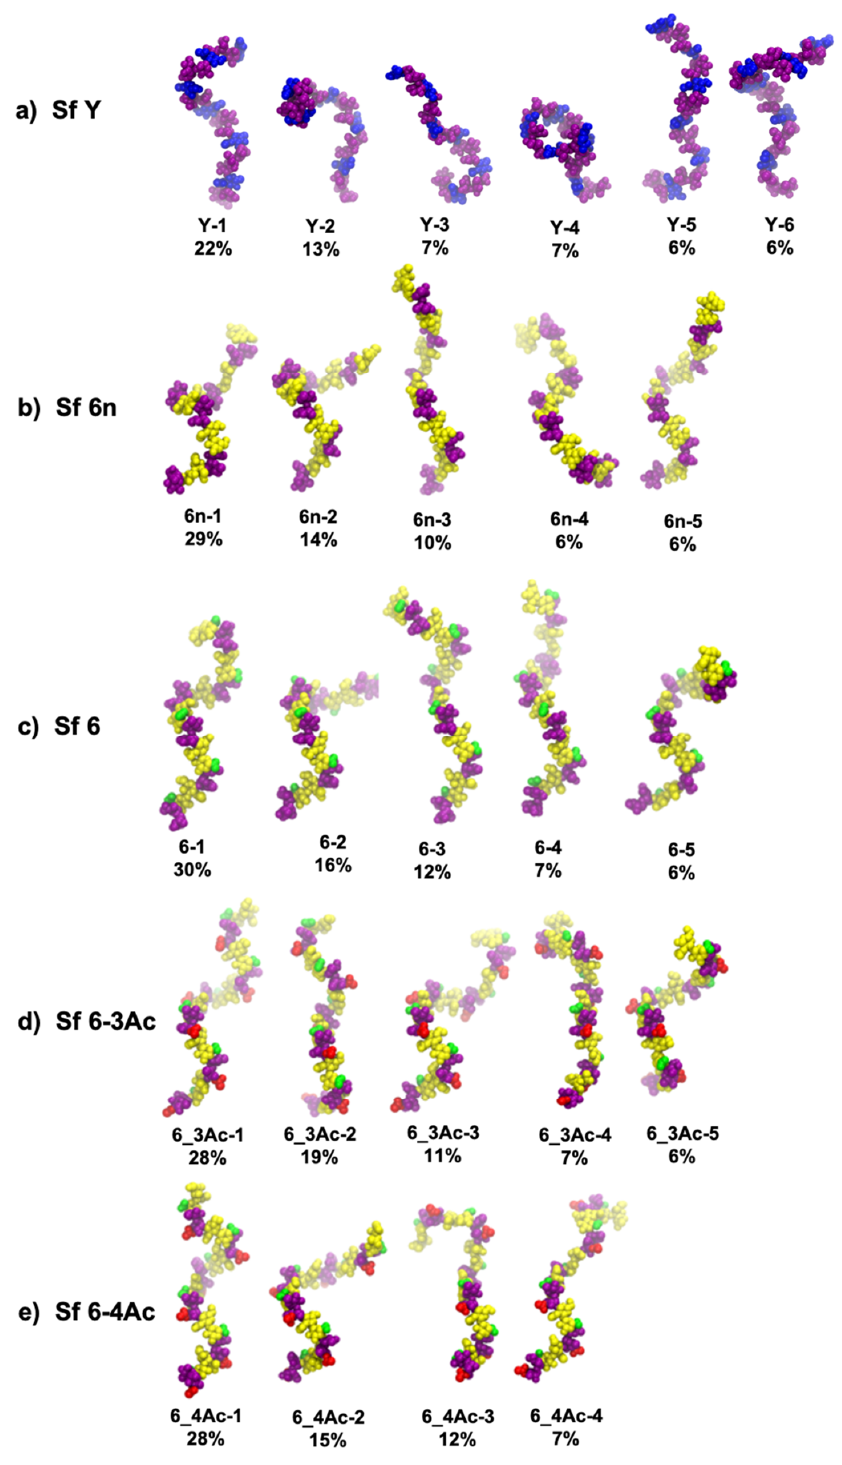
Figure 3. Dominant conformations of the middle 4 repeating units of the 6 RU O-Ag chains for S. flexneri : ( a ) Sf Y, ( b ) Sf 6n, ( c ) Sf 6, ( d ) Sf 6-3Ac, and ( e ) Sf 6-4Ac. The relative occupancies of the conformational clusters (excluding the initial 200 ns of equilibration) are shown as percentages with clusters less than 6% not shown. The color scheme is as follows: blue for Glc and GlcNAc; purple for Rha; yellow for Gal, GalA, and GalNAc; green for the COOH group of GalA; red for the O-acetyl groups.